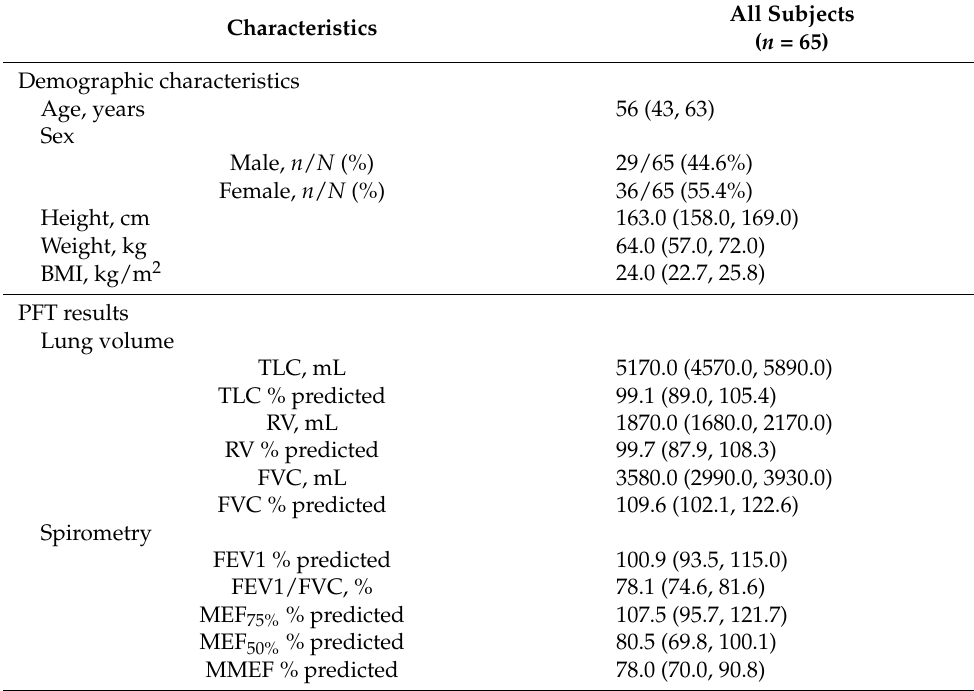
Table 1. Demographic characteristics and pulmonary function